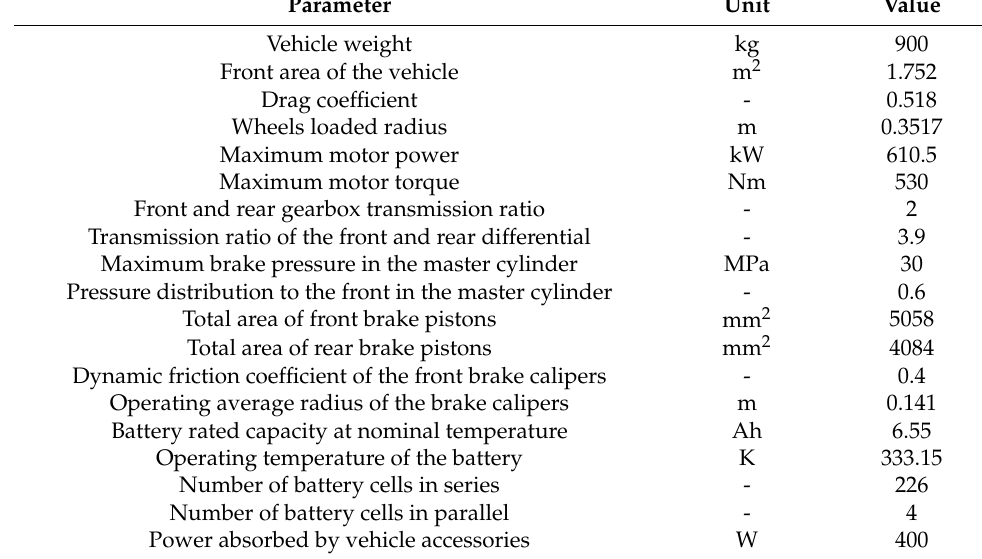
Table 5. Main data of the